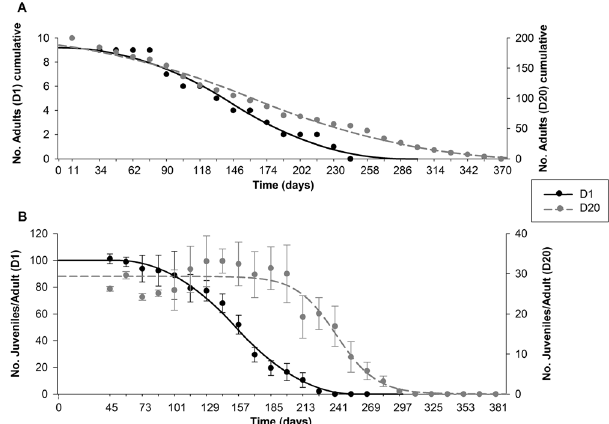
Figure 1. Lifespan test of Enchytraeus crypticus at two different organisms’ densities (1 organism (D1) and 20 organisms (D20)) in LUFA 2.2 soil, over-time. ( A ) Adults survival; all values are expressed as cumulative number (N = 10). ( B ) Reproductive output; all values are expressed as average ± standard error (N = 10). The lines represent the model fit to